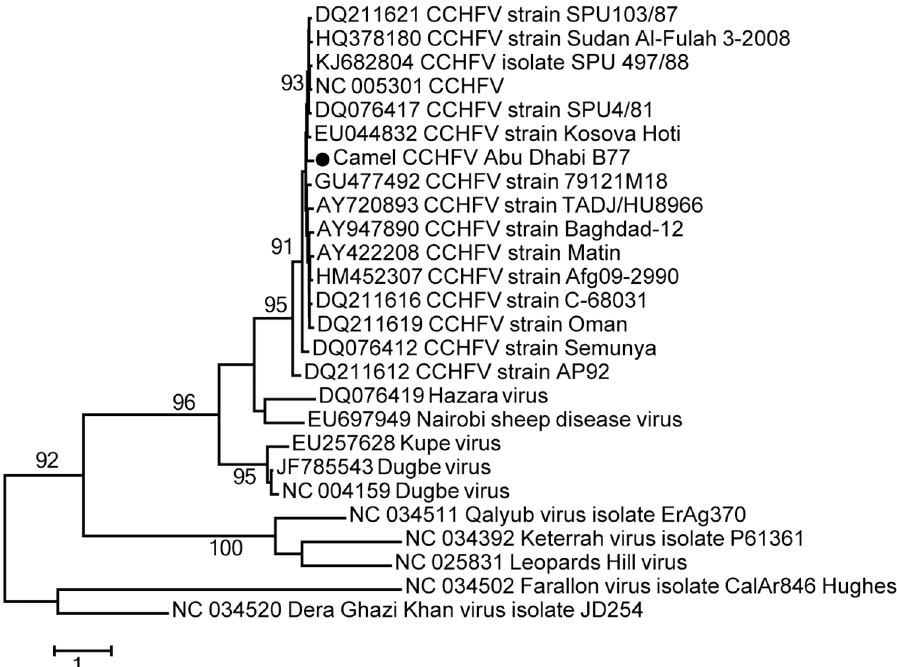
Fig 5. Phylogenetic analysis of camel CCHFV Abu Dhabi. Maximum likelihoodphylogenetic tree was estimated from the longestcontig (531 nt in L segment) obtainedand 25 previouslypublishedL segment sequencesin the Orthonairovirus genus. The representative camel CCHFV virus sequenceidentifiedin this study is highlighted by a solid circle. The scale bar indicatesthe estimated numberof nt substitutionsper site and the bootstrap values ( (cid:21) 80) are